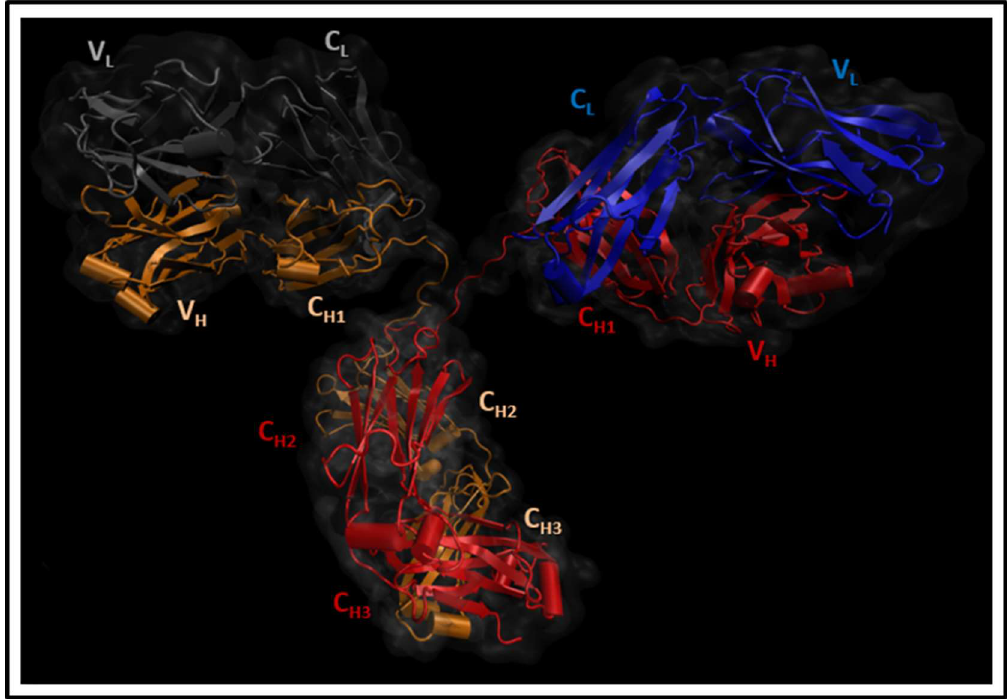
Figure 1. Antibody structure.